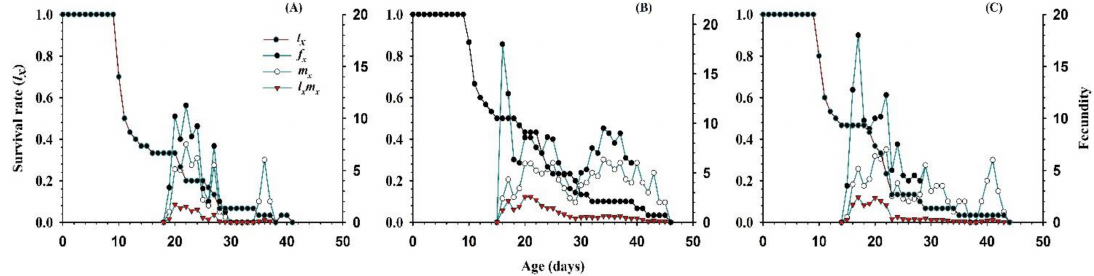
= 1st Instar, N2 = 2nd xj ) of the O. strigicollis ; N1